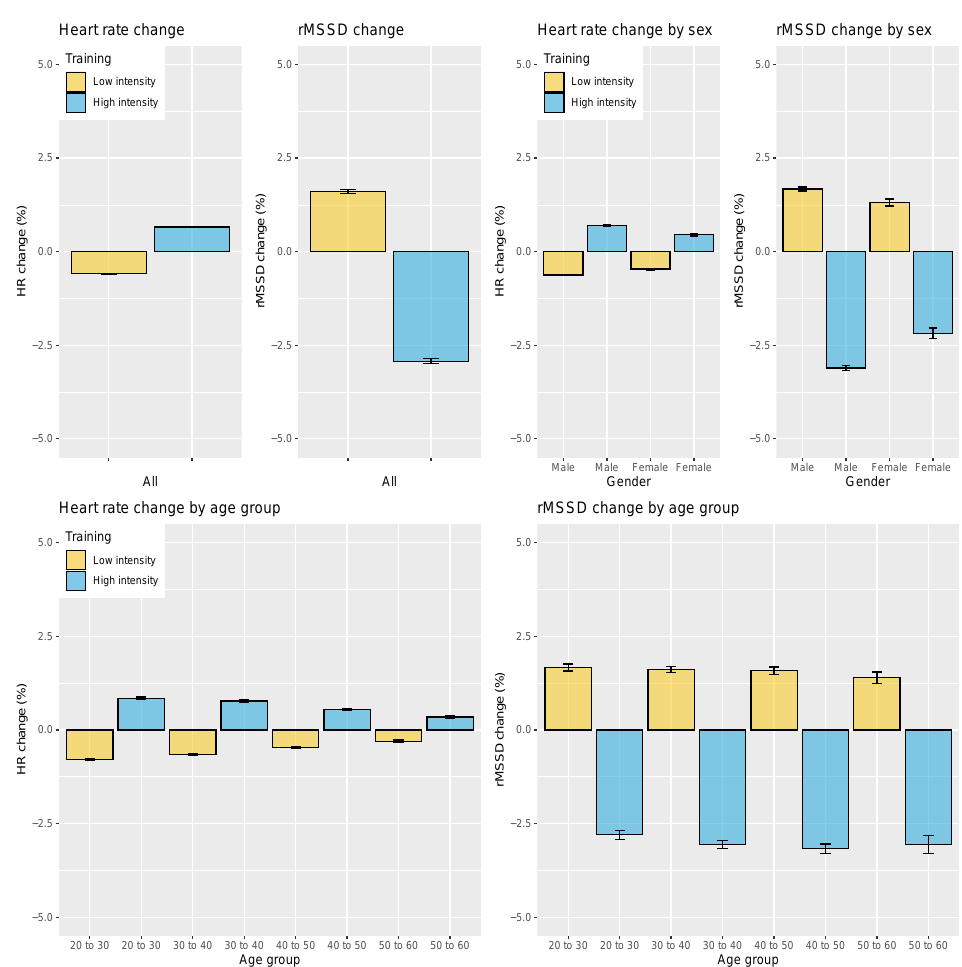
Figure 9. Relation between HR, HRV, and training load split into two categories, analyzed on the entire dataset and grouped by sex or age group. HR is consistently increased on days following higher intensity training load, while rMSSD is consistently reduced. Relative changes in rMSSD are larger, highlighting how HRV can be more discriminating for training intensity. Additionally, percentage changes in heart rate reduced with age while remaining constant for rMSSD. Error bars indicate the standard